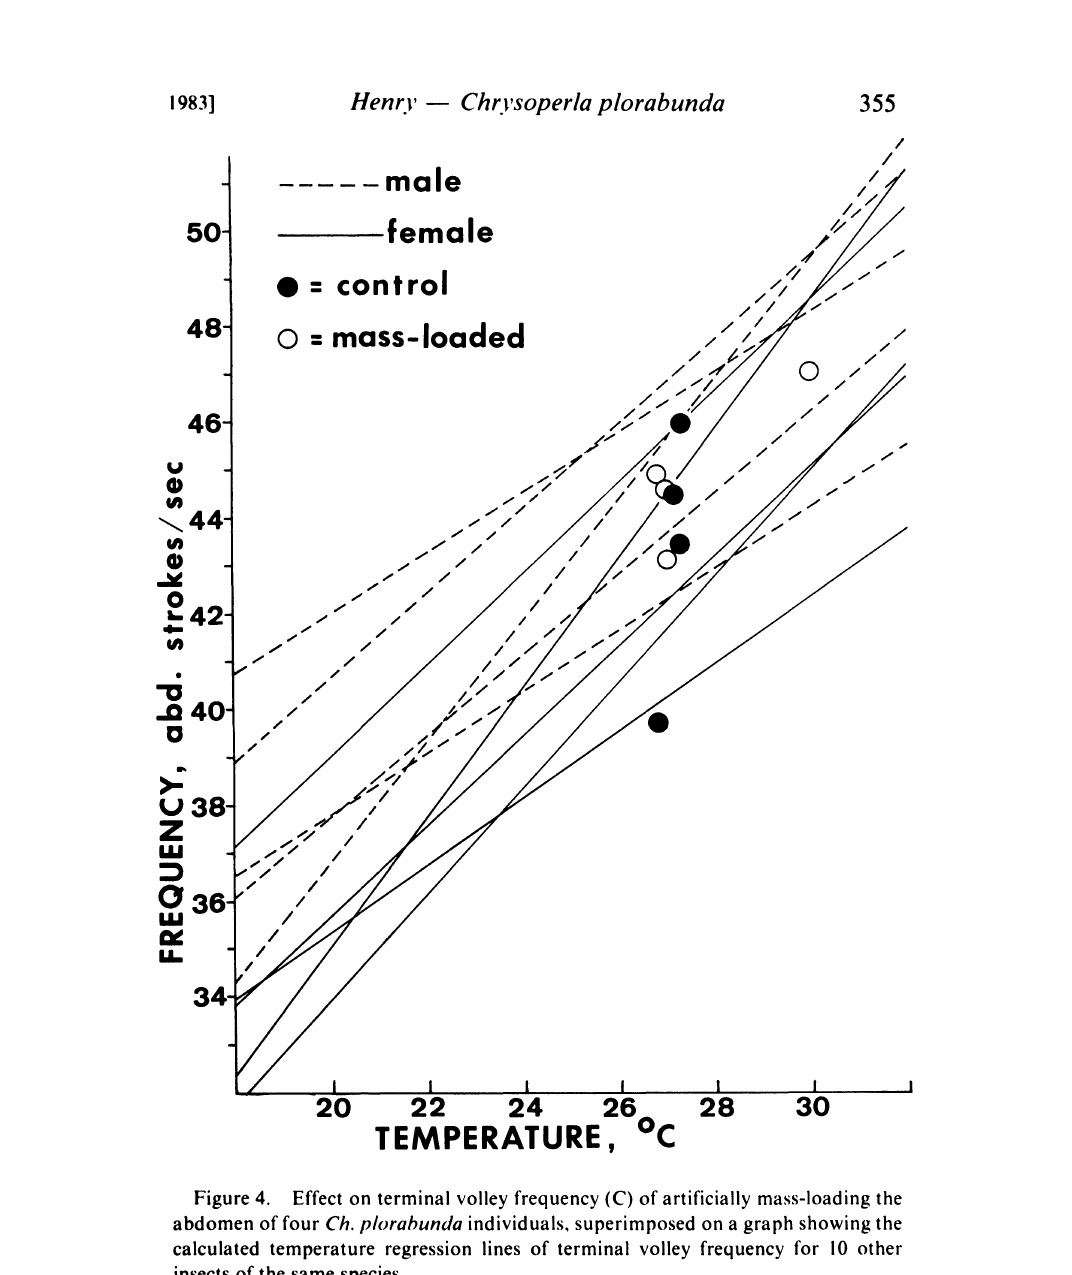
Figure 4. Effect on terminal volley frequency (C) of artificially mass-loading the abdomen of four Ch. plorabunda individuals, superimposed on a graph showing the calculated temperature regression lines of terminal volley frequency for 10 other insects of the same